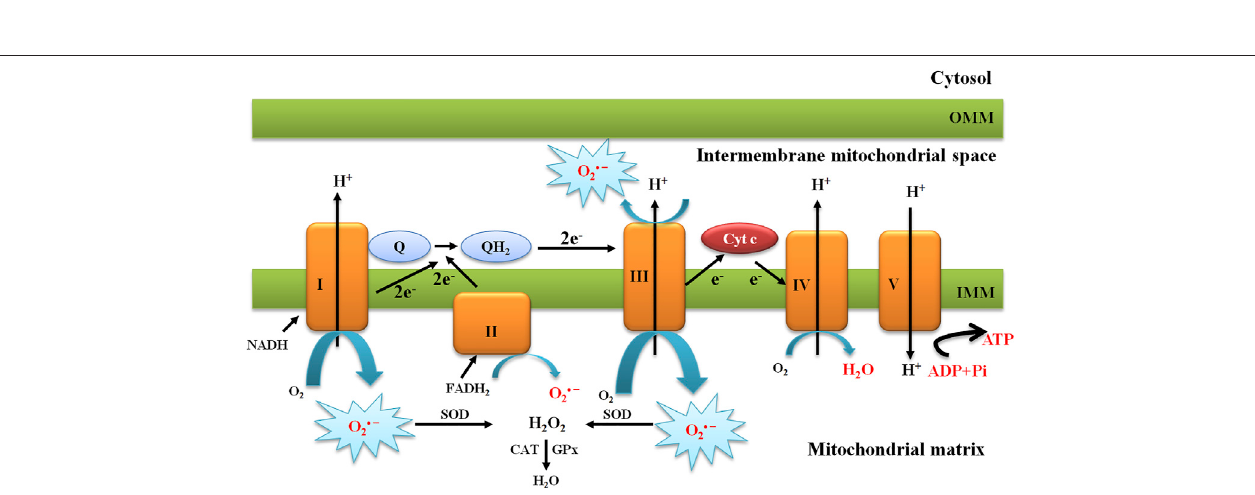
FIGURE 1 | The schematic pathway of major sources of oxidative stress (OS) and induction of DA neuron death in Parkinson ’ s disease (PD).